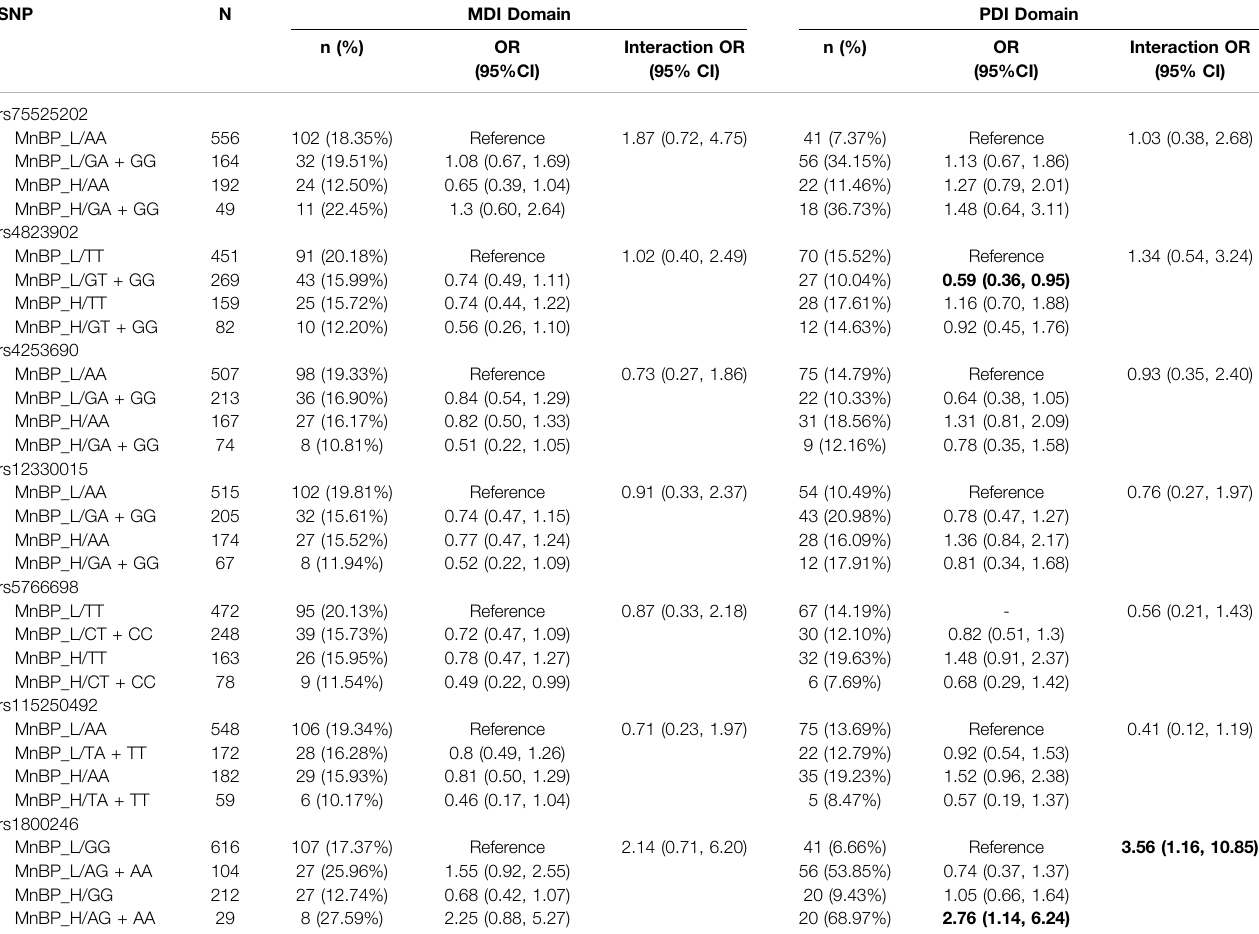
TABLE 5 | Interaction between urinary MnBP and seven selected PPAR α variants on neurocognitive developmental delay. SNP